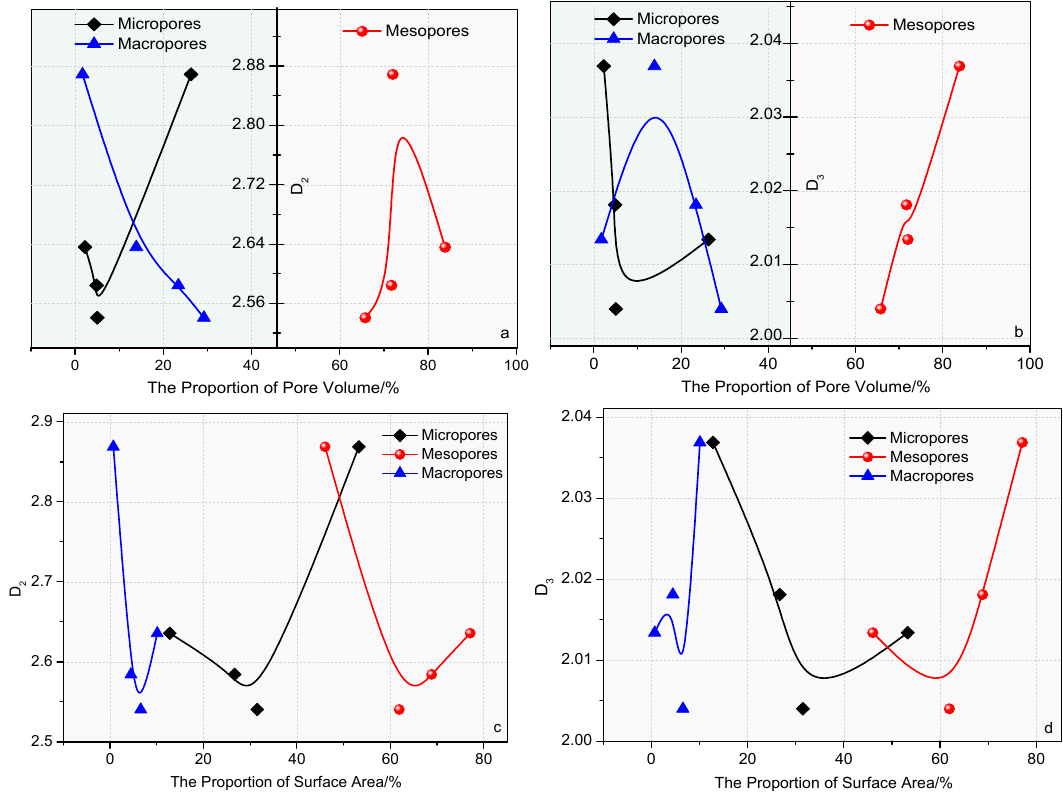
Figure 8. Relationships between proportions of pore parameters and fractal dimensions.